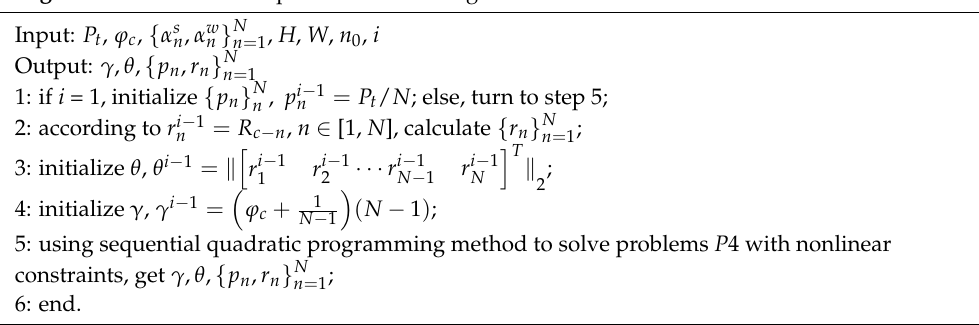
Algorithm 2: Inter cluster power allocation algorithm under fairness constraint